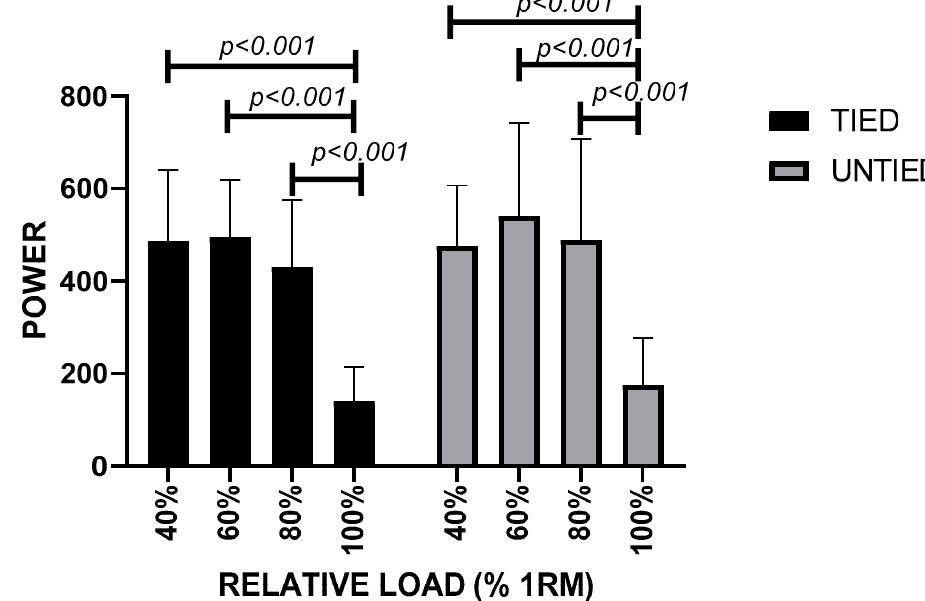
Figure 5. Power vs. relative load during bench press in untied and tied conditions with leg/bench straps in paralympic powerlifting athletes.